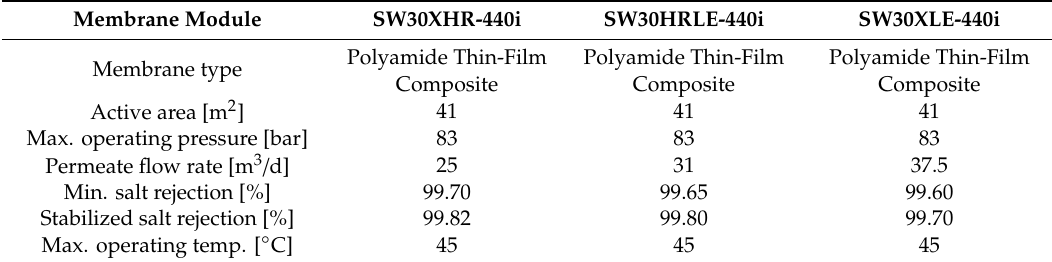
Table 3. Properties of examined reverse osmosis membrane